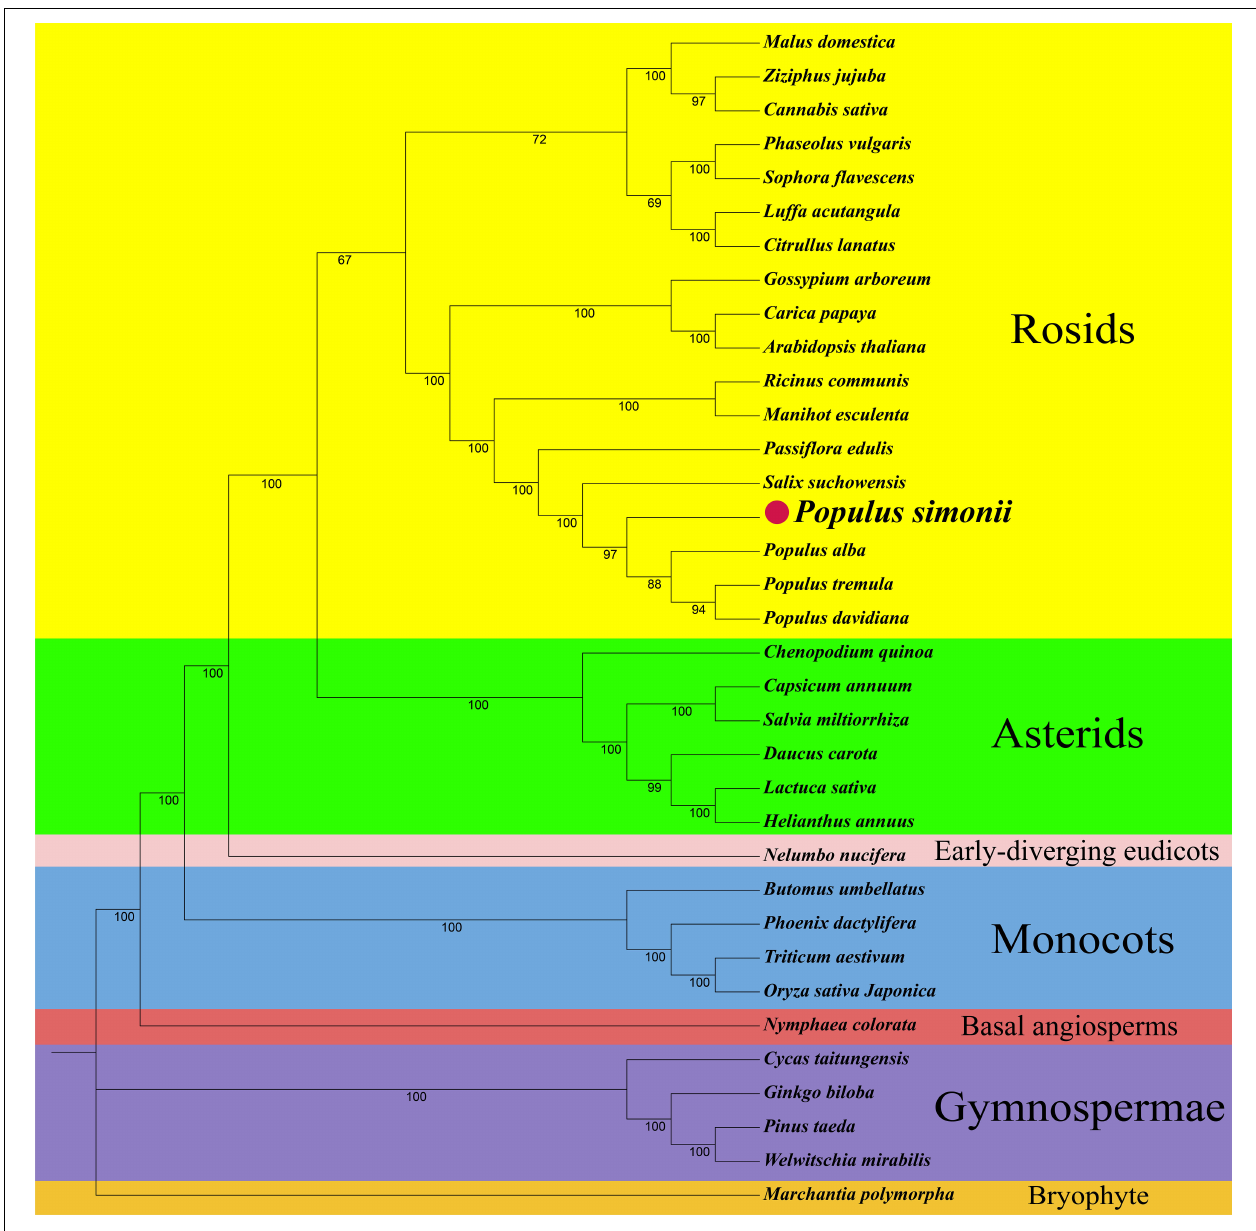
FIGURE 4 | The phylogenetic relationships of P. simonii with other 34 represented land plants. Numbers on each node are bootstrap support values. Colors indicate the families of each